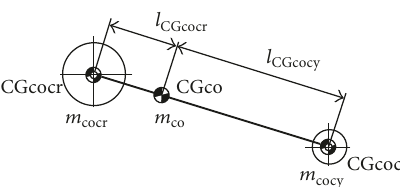
Figure 2: Equivalent dynamic model of concentrated masses of the